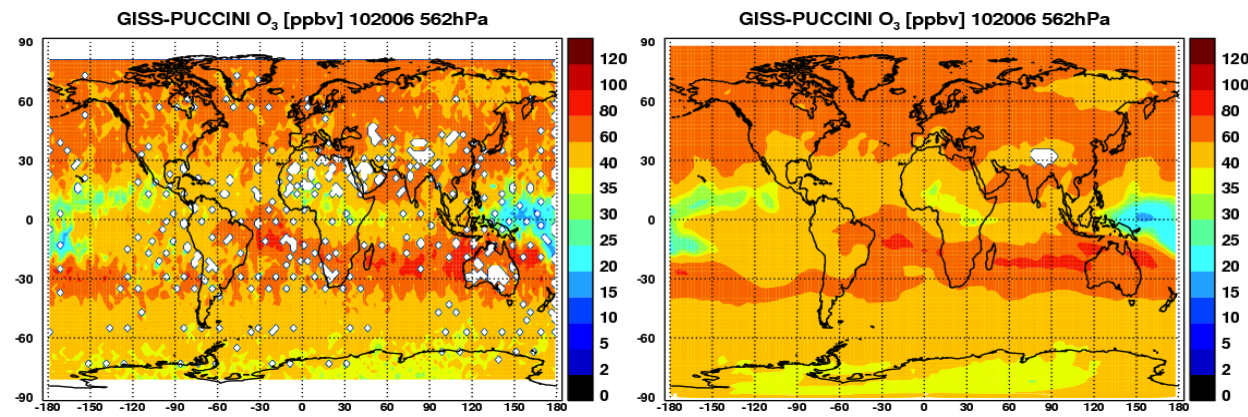
Fig. 6. The geographical distribution comparing the monthly averages of ozone computed from the points sampled from the GISS-PUCCINI model using only the spatio-temporal locations belonging to the “good” nadir points, i.e. screened (left) to the monthly mean model output computed from the entire 3-hourly time-series, i.e. no screening (right) in October 2006 at